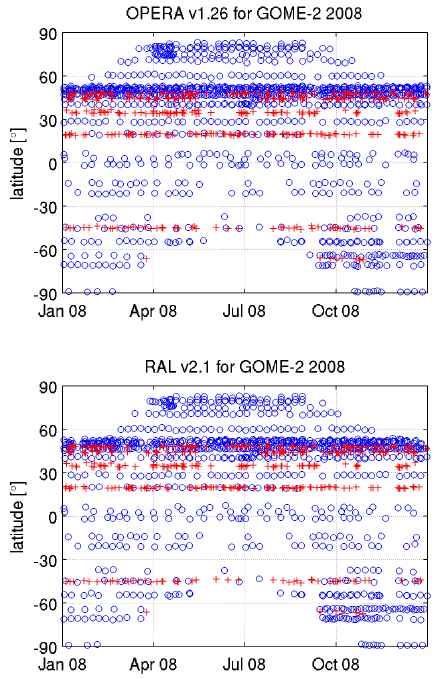
Figure 7. Latitude-time sampling of closest co-locations between OPERA v1.26 and RAL v2.1 nadir ozone profile retrievals of GOME-2 (2008) observations on the one hand, and ground-based ozonesonde (blue circles, 200km and 2h distance at maximum) and lidar (red crosses, 200km and 12h distance at maximum) measure- ments on the other hand. Latitude values correspond to the satellite position during measurement. Ground measurements are obtained from the NDACC, SHADOZ, and WOUDC